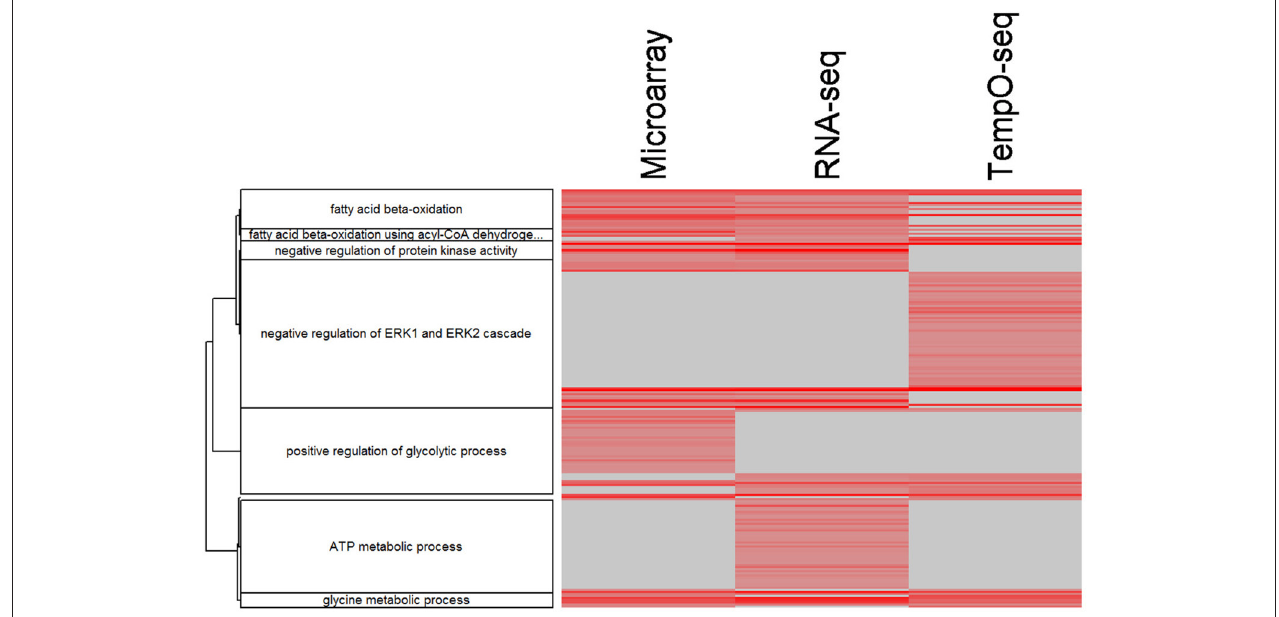
FIGURE 8 | Clustering of enriched GO BPs. goSTAG clustering of 203 enriched GO BPs using 5 genes per category, BH FDR < 0.05, correlation distance (1-Pearson correlation) and Ward clustering, dendrogram threshold = 0.9 and minimum number of GO BP terms per cluster = 5. Data is the –log 10 p -value. The more red the intensity, the more significant the enrichment. Gray indicates that the GO BP term was not enriched significant and thus the p -value was imputed with 1.0.